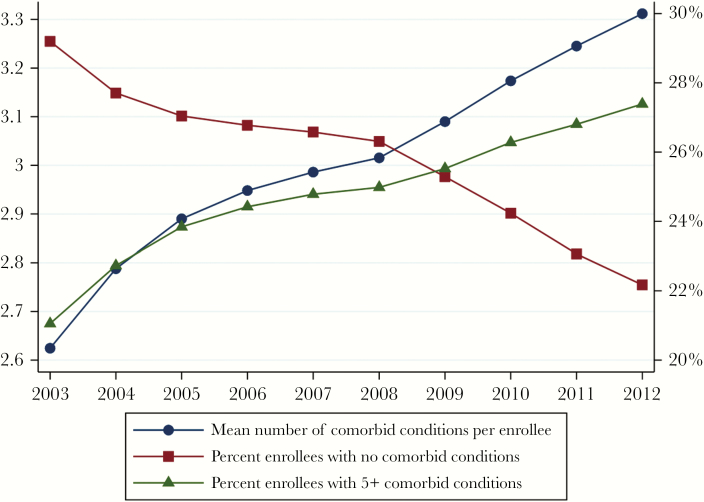
Number of comorbid conditions among HIV Medicaid enrollees, 2003–2012. n = 5 848 394 person-quarters. All yearly estimates have P values <.001. The denominator includes all eligible HIV Medicaid enrollees in the analytic cohort. The numerators include all patients who had evidence of the number of conditions in the last 24 months, as documented in claims. Rates were adjusted for months of eligibility and not adjusted for patient characteristics. The left y-axis represents the mean number of comorbid conditions/enrollee, and the right y-axis represents the percentage of enrollees with either 0 or 5+ comorbid conditions.